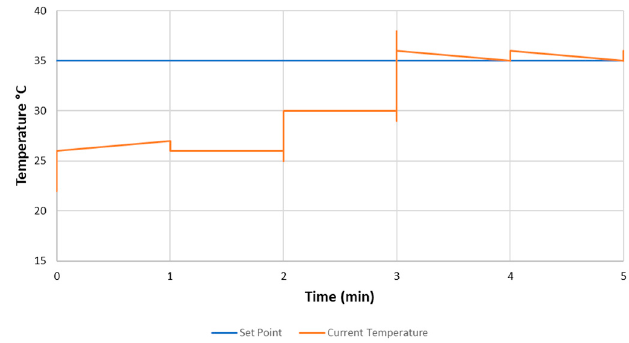
Figure 4. Internal chamber temperature increasing to the user-defined set-point of 35 °C.